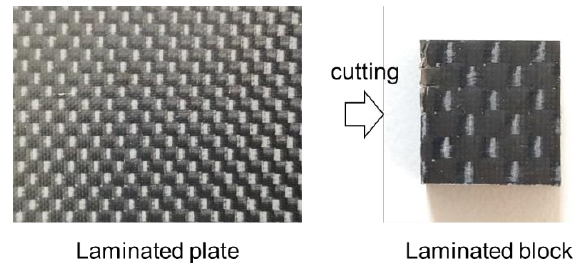
Figure 3. Plain woven laminated composite.